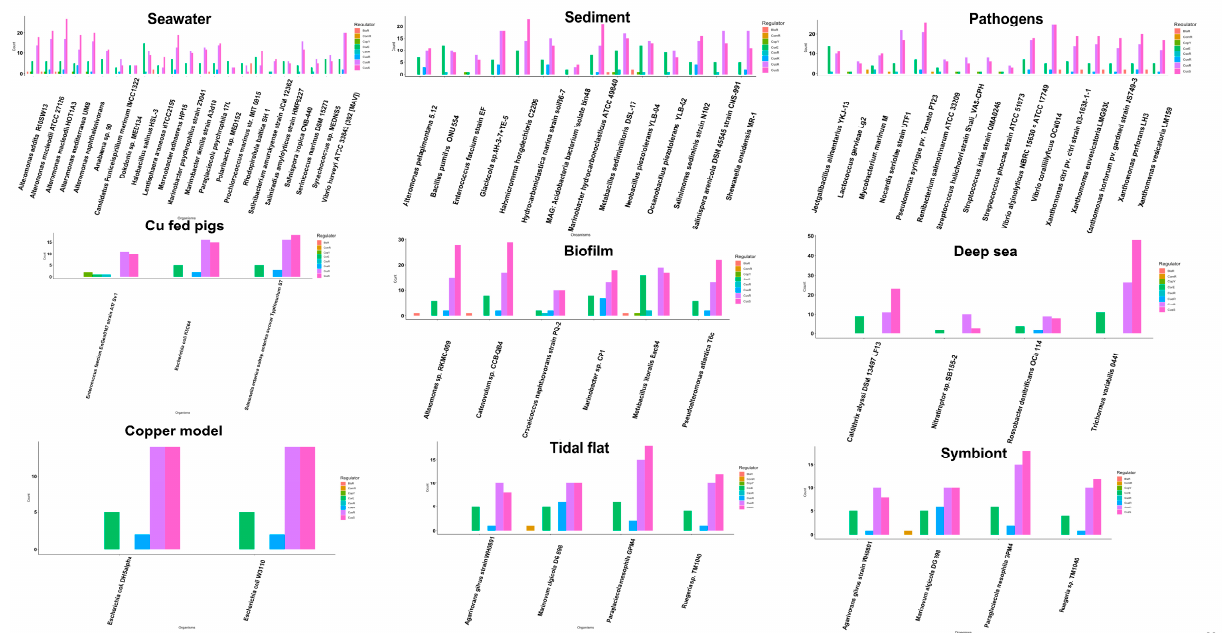
Figure 4. Number of hits to copper-associated signal transduction system in marine bacteria classified according to their isolation source. The copper-associated system homolog hit count was plotted against each bacterial strain, and each bar color represents a different regulatory system. Panels represent bacterial strains classified based on the isolation source.